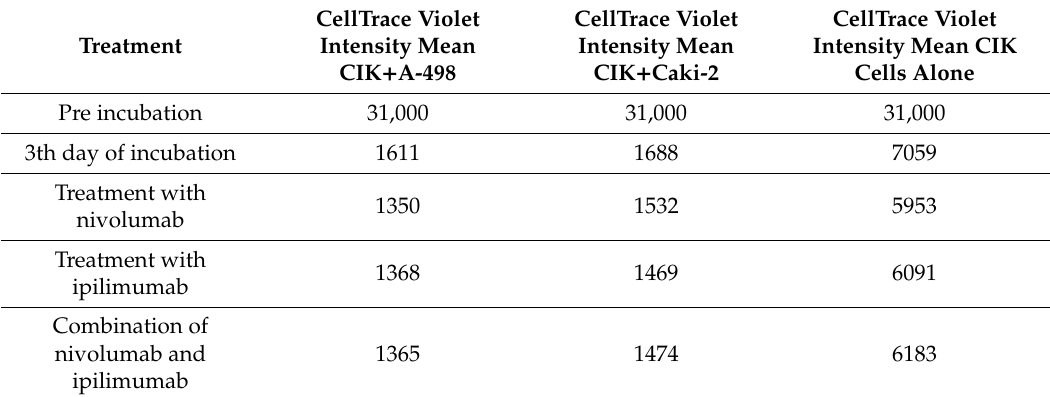
Table1. MeanintensityofCellTrace TM violetofmajorCIKcellspopulationsmeasuredbyflowcytometry analysis after 72 h of the CIK cells co- and monoculture with A-498 and Caki-2. Representative data from one donor. We analyzed the proliferation of labeled renal cells and e ff ects of CIK cells and respective treatments on their proliferation and